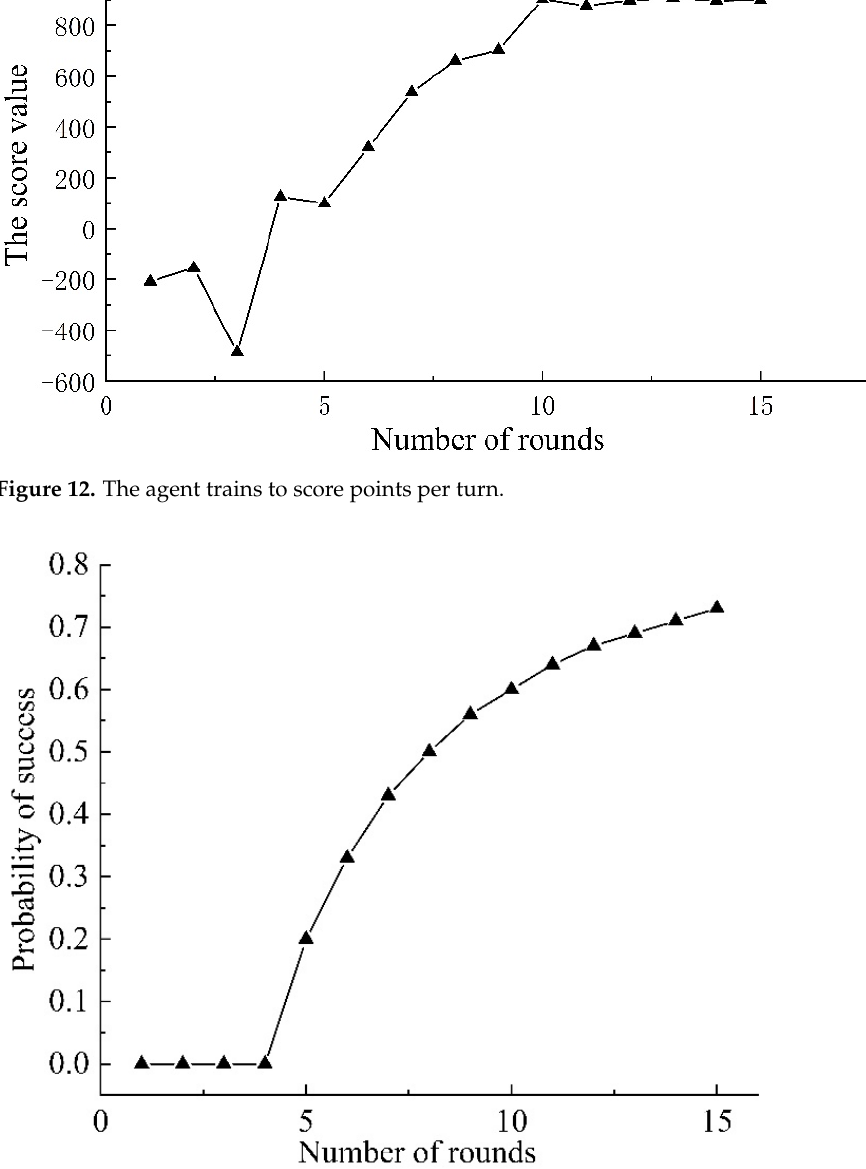
Figure 13. Agent training success rate.